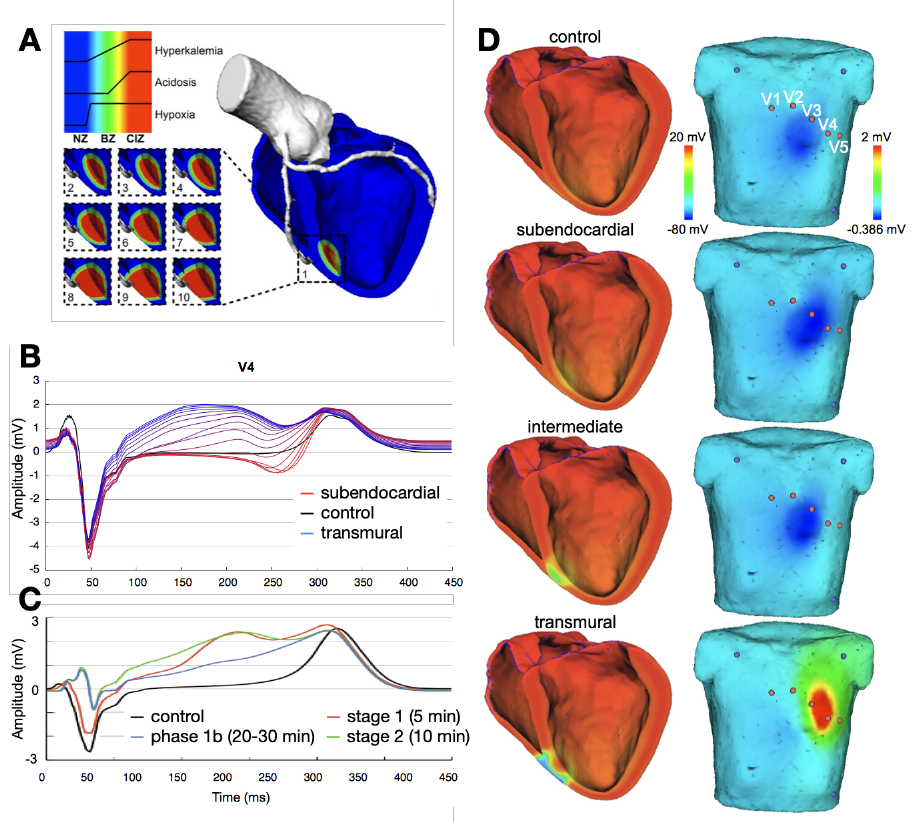
Figure 2. Examples of ischemic regions with varying transmural extent due to occlusion of the left anterior descending coronary artery and the related levels of hyperkalemia, acidosis, and hypoxia ( A ). ECG lead V4 for ischemia of varying transmural extent in temporal stage 2 ( B ) and varying duration of a transmural ischemia ( C ). Ventricular transmembrane voltage and body surface potential distribution during the action potential plateau (t = 200ms) for ischemia of varying transmural extent in stage 2 ( D ). The QRS complex was not optimized in this study. (Images reproduced with permission from [28].) Ledezma et al. created populations of control and ischemic cell strands and observed the corresponding pseudo-ECGs (which is the voltage between two virtual electrodes at or near to the ends of a tissue strand immersed in an infinite homogeneous volume